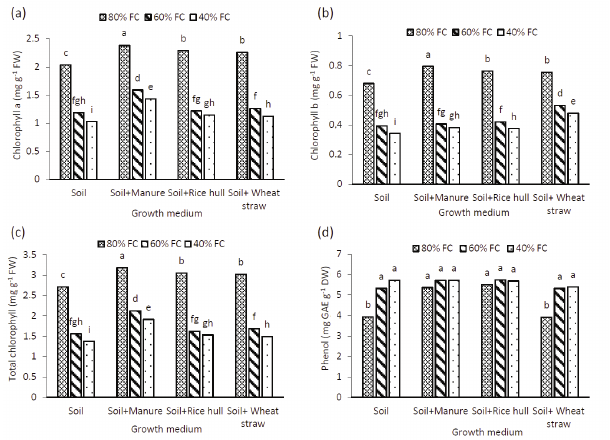
Fig. 4 ­ Chlorophyll a (a), chlorophyll b (b), total chlorophyll (c), phenol (d) in hollyhock plants under different medium. Values in columns followed by the same letter are not significantly different at the 0.05 level (P≤0.05).